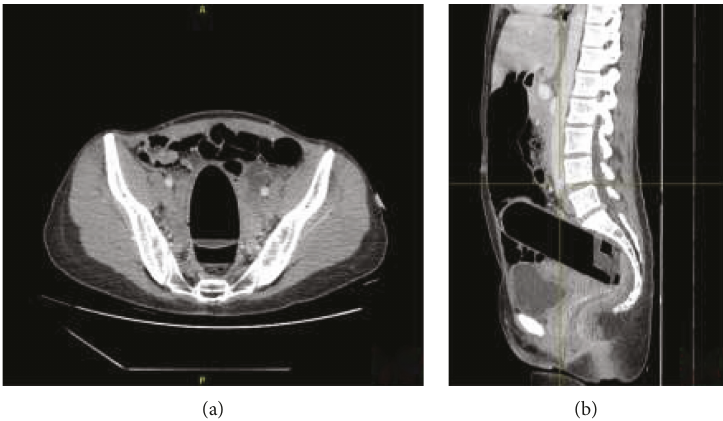
Figure 2: The visualization of the foreign body by CT: axial view (a) and sagittal view (b).